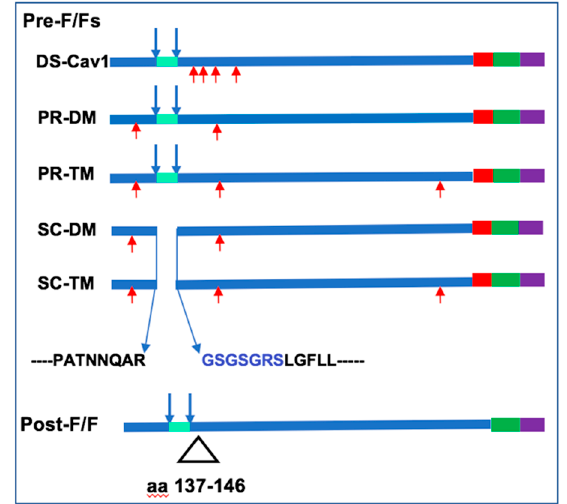
Figure 1. Fusion Protein Chimeras. Shown is a diagram of five different versions of mutation stabilized RSV pre-fusion F proteins used in this study. DS-Cav1 protein containing four mutations (red arrows) has been previously described [16] PR-DM and PR-TM are processed (cleaved) F proteins with two or three mutations, respectively, indicated by red arrows. SC-DM and SC-TM are uncleaved with the p27 sequence and cleavage sites deleted and a linker sequence, in blue, inserted. SC- DM and SC-TM also contained two or three mutations, respectively, indicated by red arrows. All Pre-F proteins contained the ectodomain of the RSV fusion protein fused to the foldon sequence (red), the NDV transmembrane (green), and cytoplasmic (purple) domains. Post-F/F protein contained the deletion indicated.